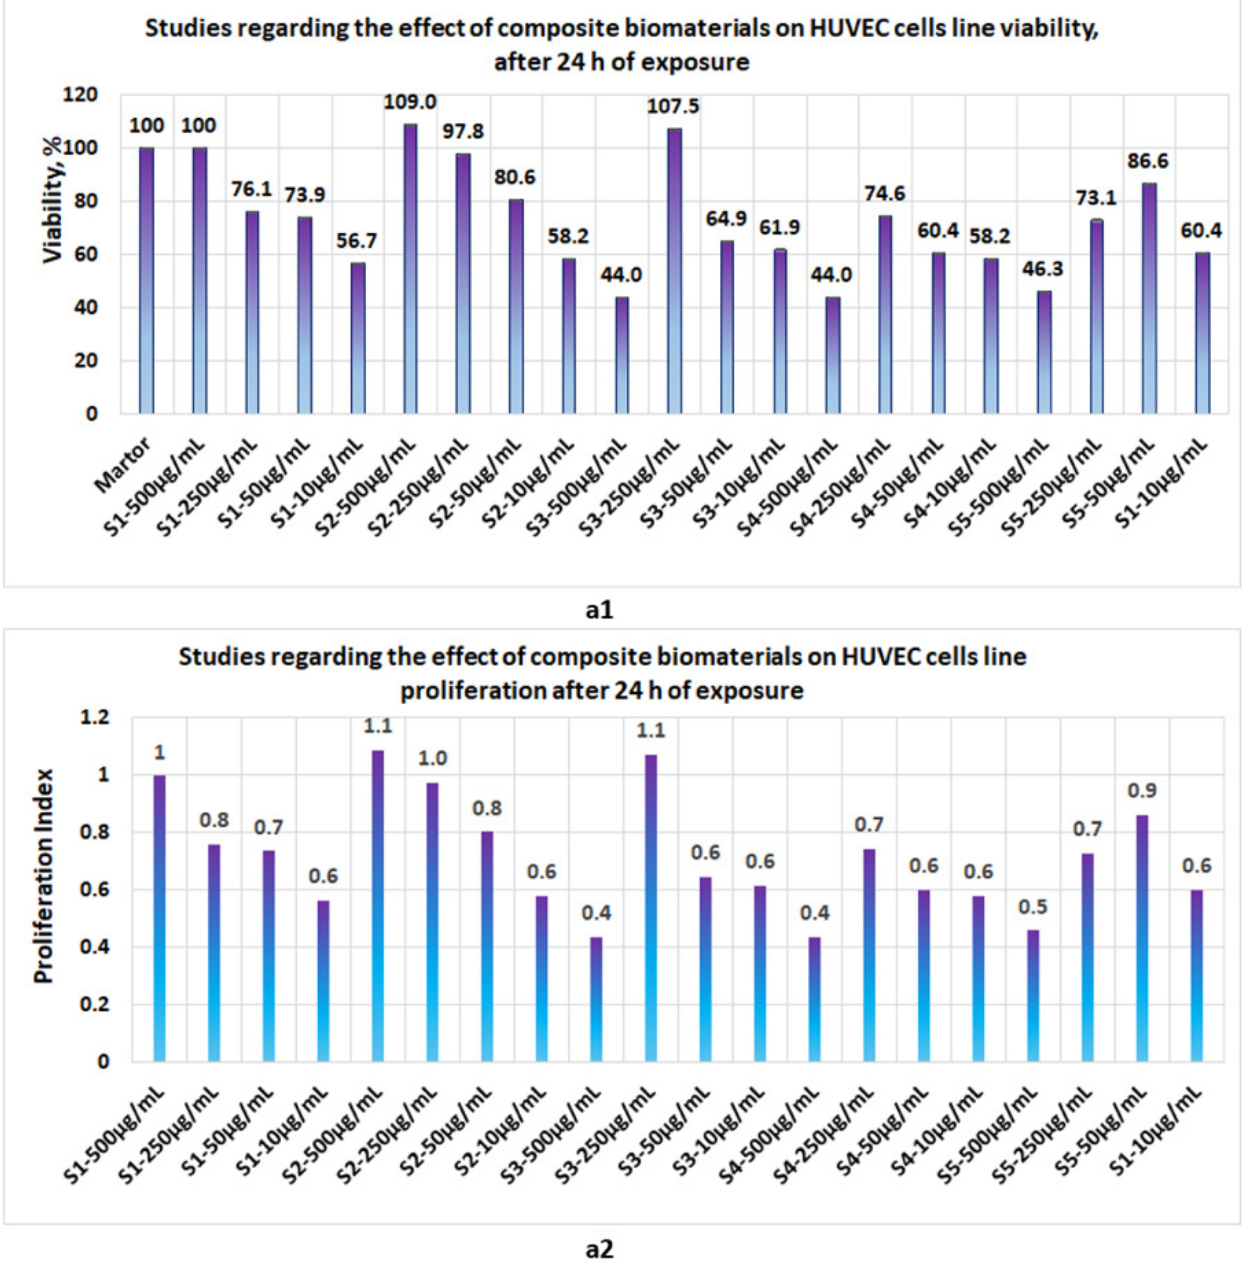
Figure 12. Studies regarding the effect of composite biomaterials on HUVEC cell lines after 24 h of exposure; ( a1 ) influence on cell viability; ( a2 ) influence on cell proliferation.